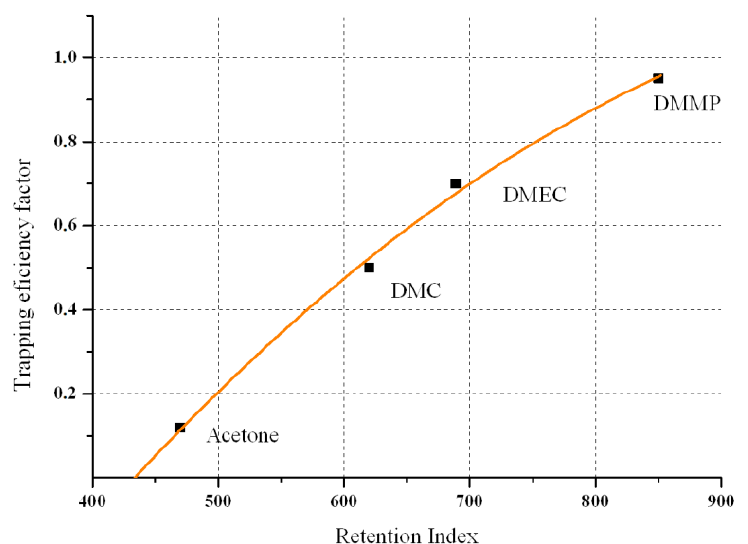
Figure 2. Experiment data on the capture coefficient with a sample volume of 0.5 L, given as a function of the chromatographic retention index.